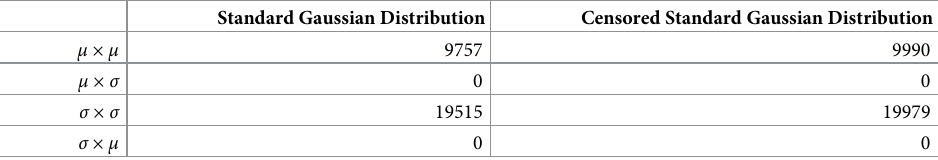
Table 1. Fisher information censored by remapping N ( μ = 0, σ = 1)